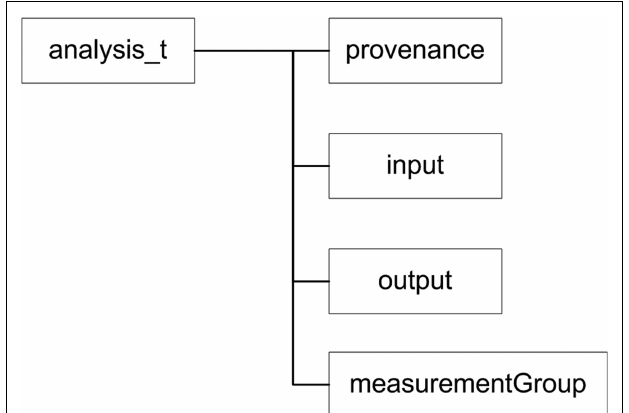
to store derived data values directly in XML formatted fi le. The provenance and processStep components (panel C ) used for documenting processing pipeline specifi c